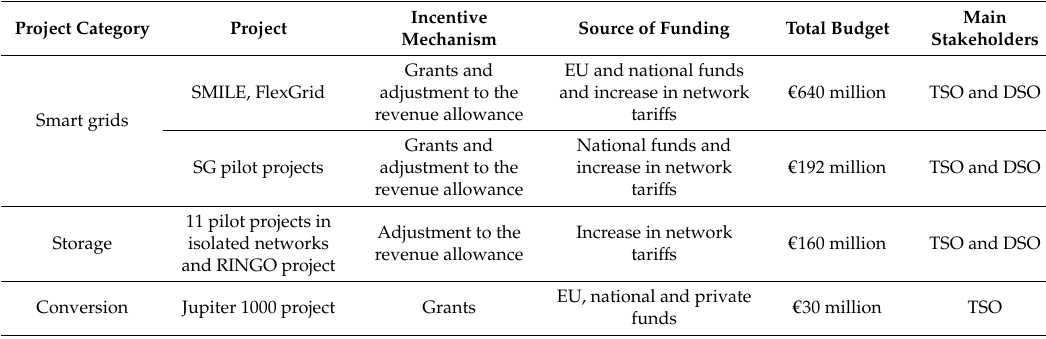
Table 3. Overview of network innovation projects in France.